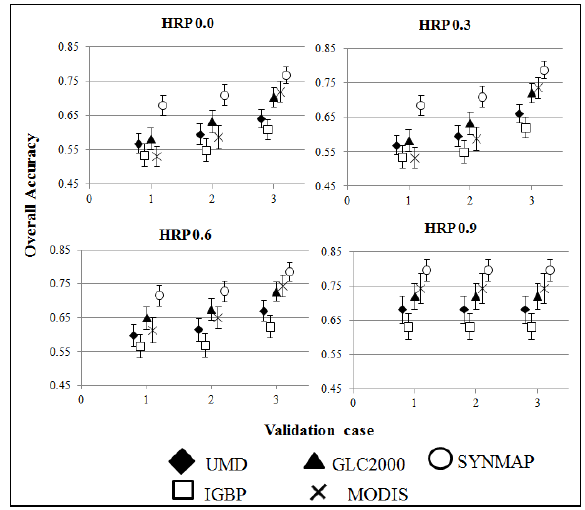
Figure 5. Overall accuracy for the maps in different validation case and HRP